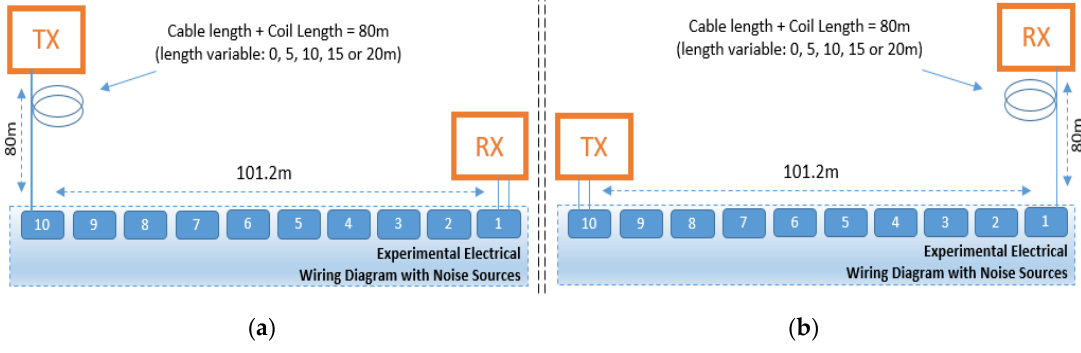
Figure 5. Verifying the influence of Inductance on the PLC channel. ( a ) next to the transmitter; and ( b ) next to the receiver.